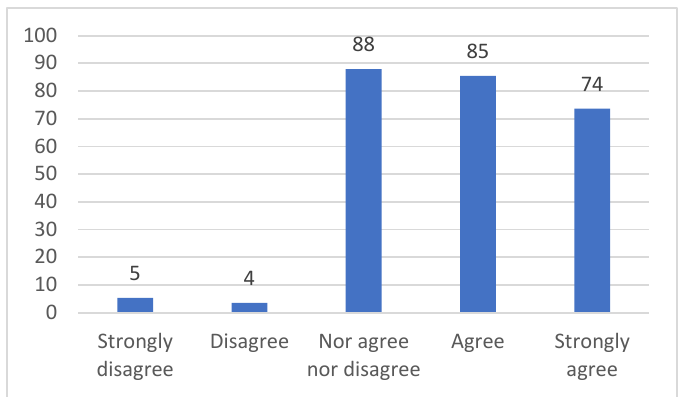
Figure 12. Answers to question 3: The sessions “Applications of Multivariable Calculus in Engineer- ing” let students know technological applications of different mathematical concepts.